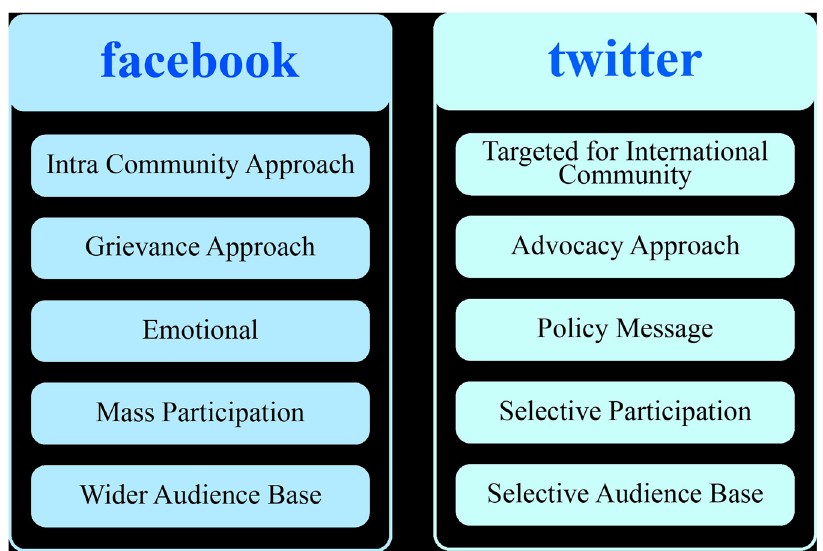
Fig. 1 The difference in issues and characteristics between Facebook and Twitter. Rohingya diaspora on Facebook and Twitter: a comparative re fl ection.